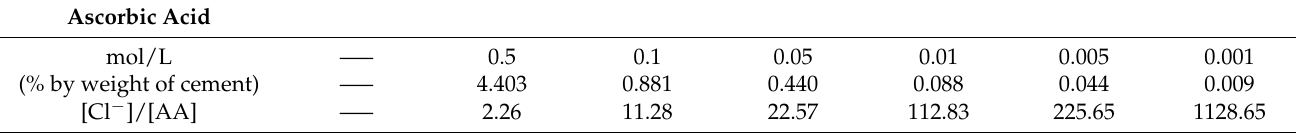
Table 2. Ascorbic acid dosage in mortar specimens and cement